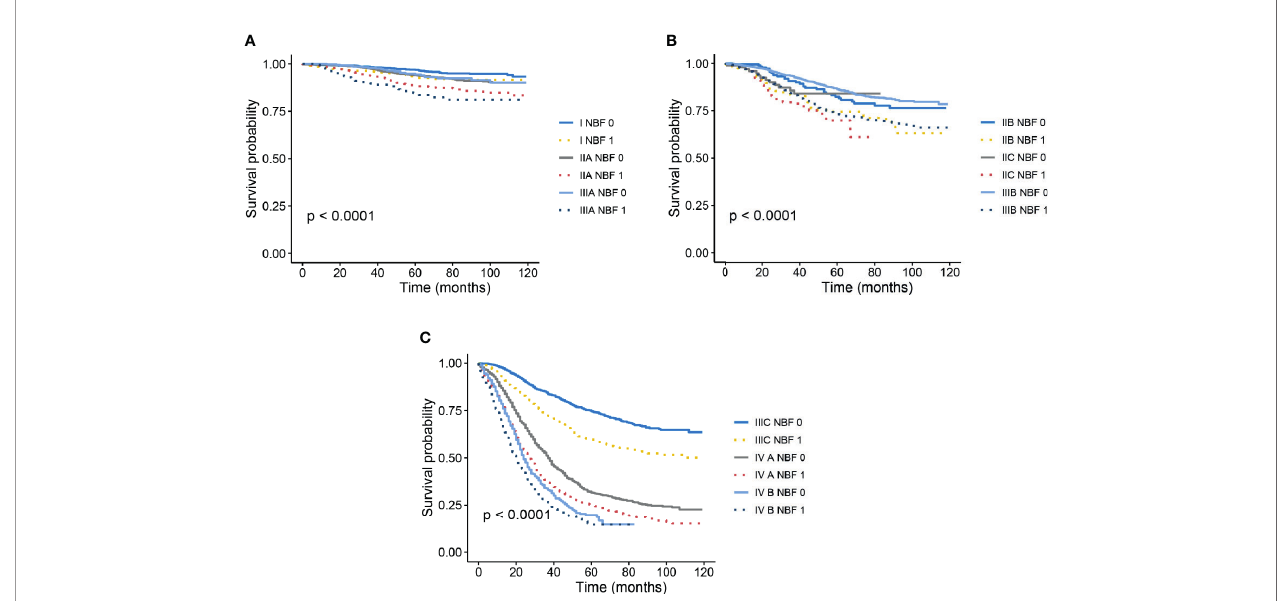
FIGURE 4 | Kaplan – Meier survival curves of NBF-TNM staging system. (A) Cancer-speci fi c survival (CSS) of I-NBF 0 stage, I- NBF 1 stage, IIA-NBF 0 stage, IIA- NBF 1 stage, IIIA- NBF 0 stage, and IIIA- NBF 1 stage. (B) CSS of IIB- NBF 0 stage, IIB- NBF 1 stage, IIC- NBF 0 stage, IIC- NBF 1 stage, IIIB- NBF 0 stage, and IIIB- NBF 1 stage. (C) CSS of IIIC- NBF 0 stage, IIIC- NBF 1 stage, IVA- NBF 0 stage, IVA- NBF 1 stage, IVB- NBF 0 stage, and IVB- NBF 1